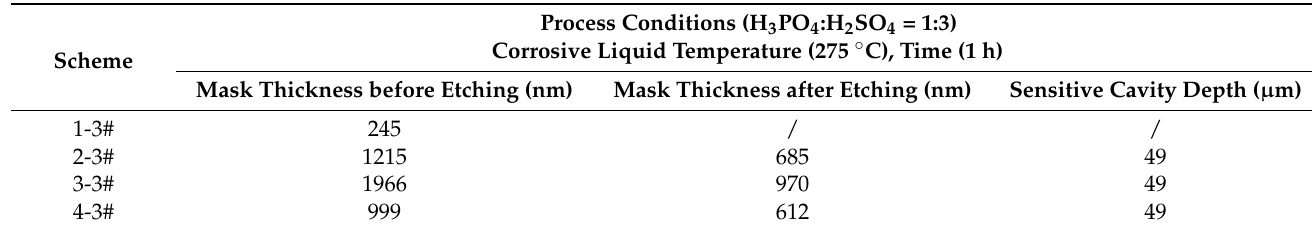
Table 4. Process results at 275 ◦